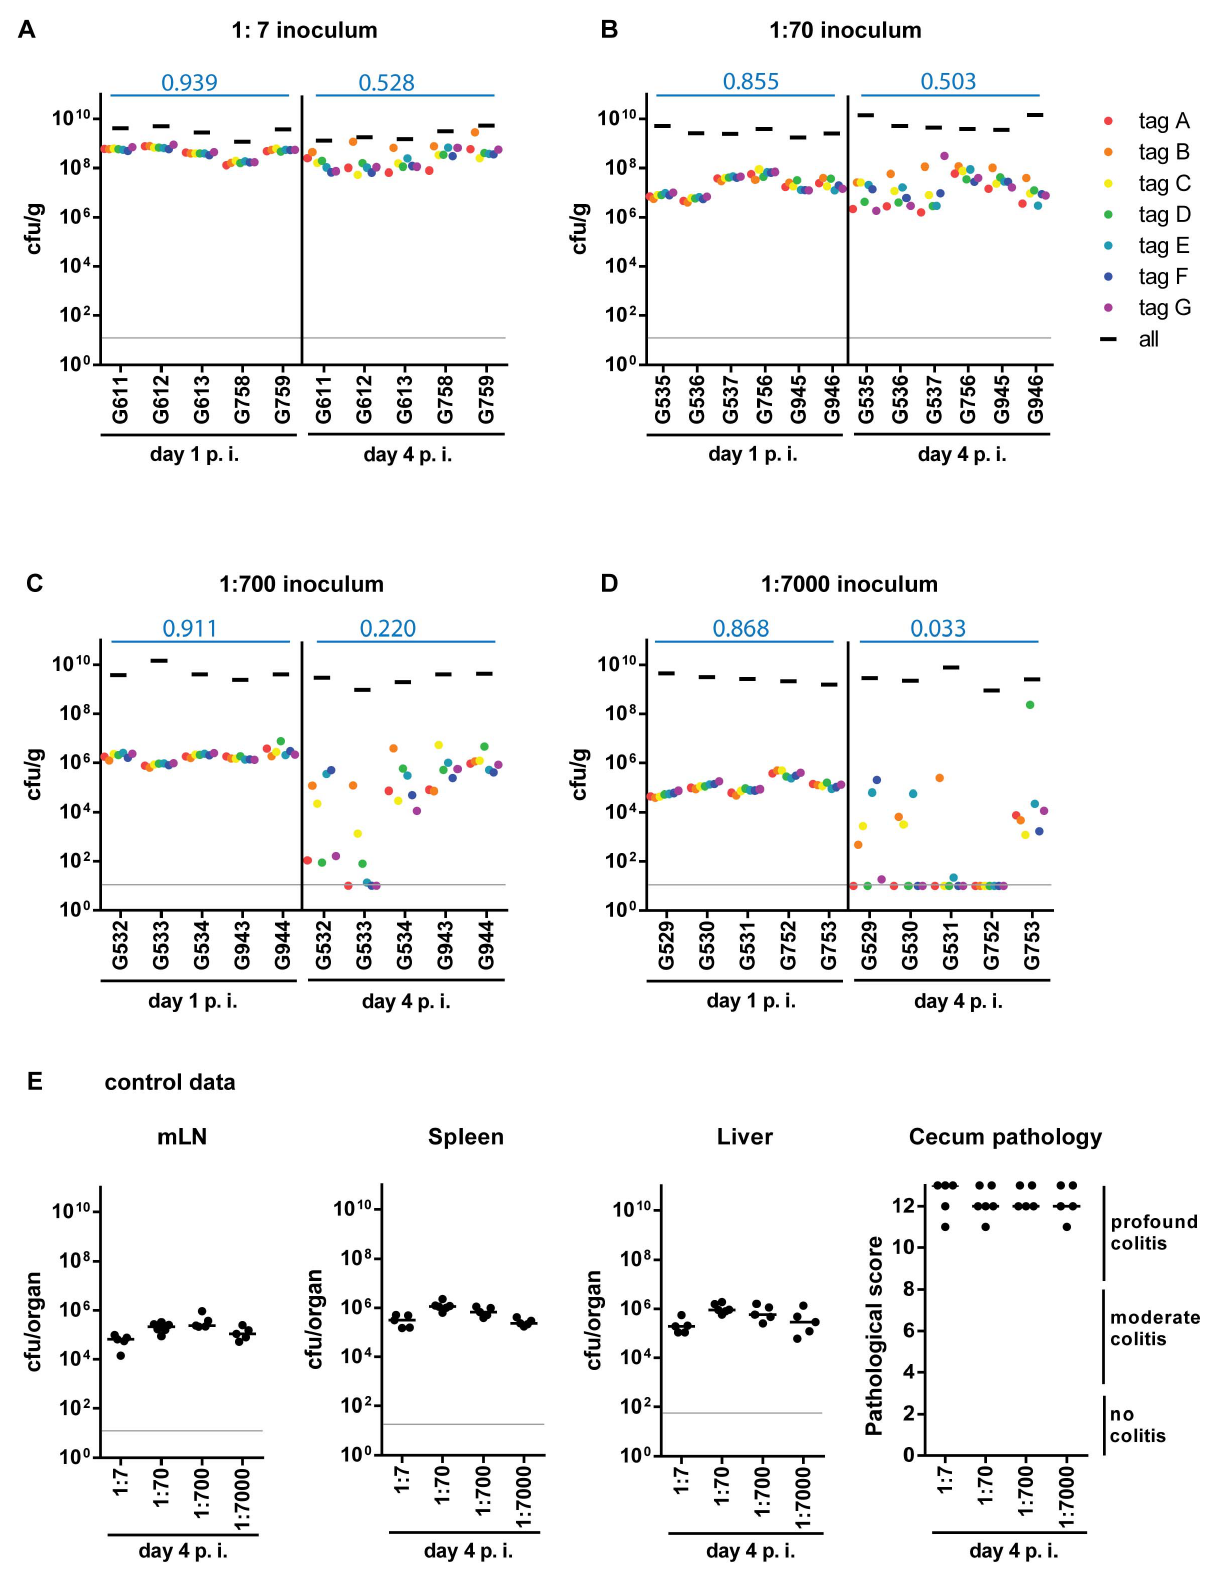
Fig. 1. Systematic dilution experiments of the tagged S. Tm WT strains allow assessing the level of WITS diversity loss. Infections were performed by diluting the tagged S. Tm WT WITS with the untagged isogenic strain to a final proportion of (A) 1:7, (B) 1:70, (C) 1:700, (D) 1:7000 of each strain. The population composition was monitored in fecal samples at day 1 post infection (day 1 p.i.) and in cecal content at day 4 post infection (day 4 p.i.) of each mouse (individual mouse identifiers were plotted on the x-axis). The cfu/g fecal or cecal content for the whole population and each